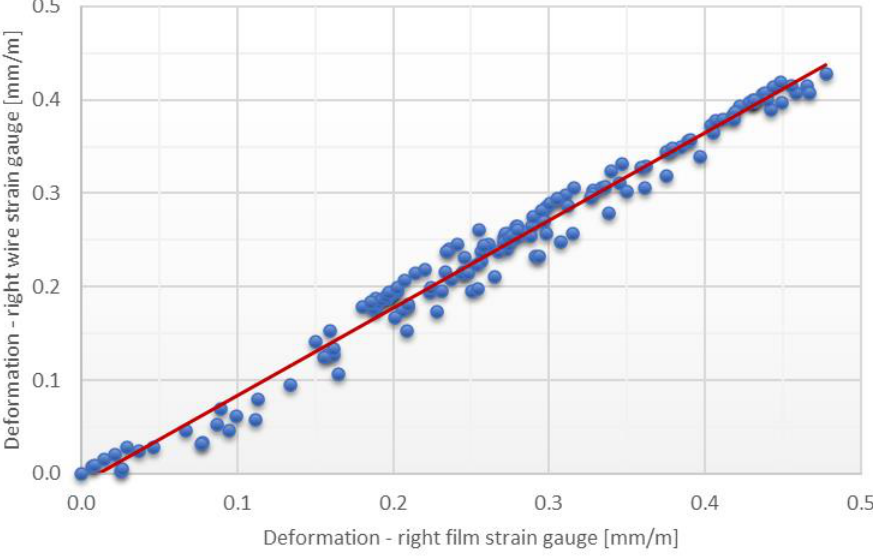
Figure 19. Scatter plot—relation between deformation measurement film strain gauge and wire strain gauge (left side of arch support frame).